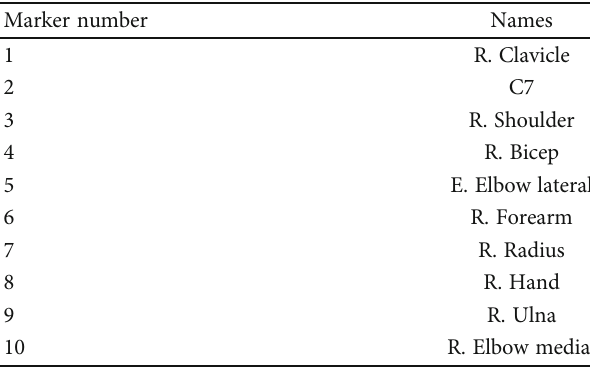
Figure 6: Ten marker locations following the International Society of Biomechanics Table 1: Markers corresponding names.